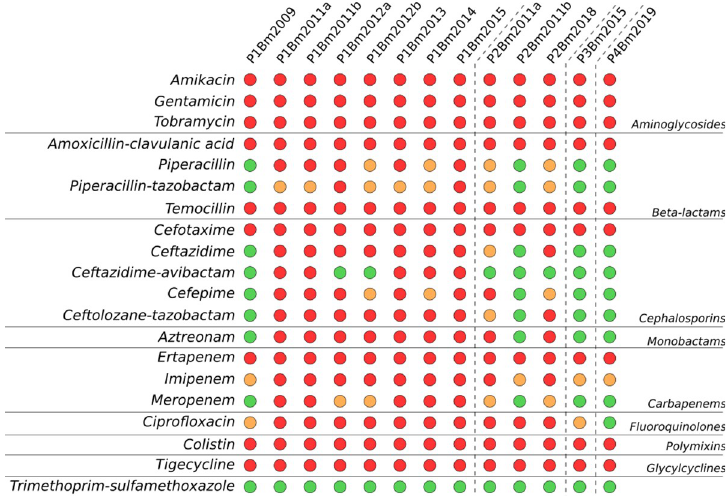
Fig 2. Antibiotic resistance profiles of the thirteen isolates. MIC values (Table B in S1 Tables) were interpreted using the EUCAST or PK/PD when available, and the results are summarized visually: Red = resistant, orange = low level of resistance, and green = sensitive.